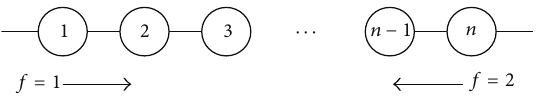
Figure 1: The representation of an urban transit rail